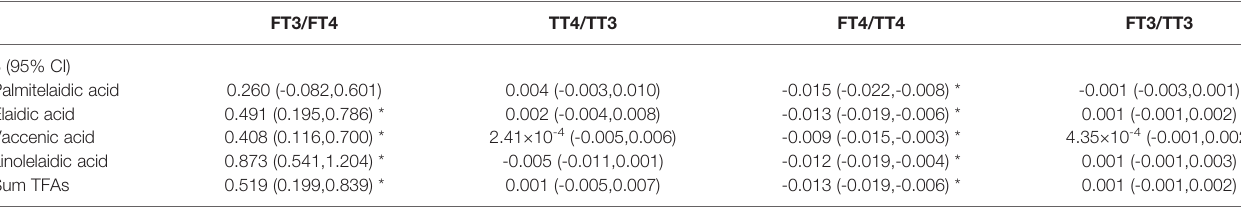
TABLE 4 | Multivariate regression analyses of log-transformed serum TFAs in relation to ratios of thyroid function